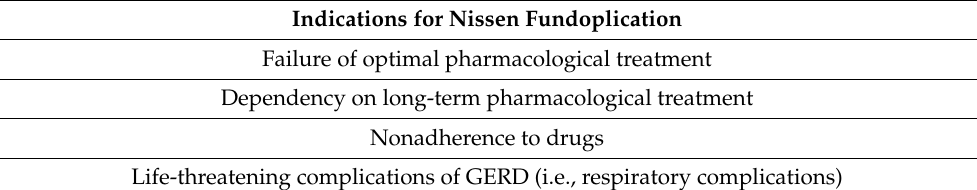
Table 2. Indications for Nissen